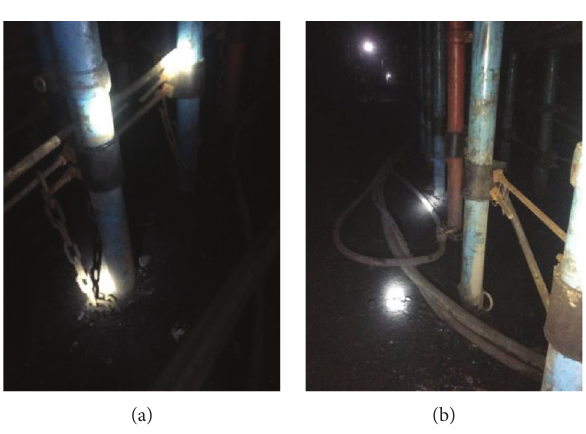
Figure 2: Single pillars drilling into